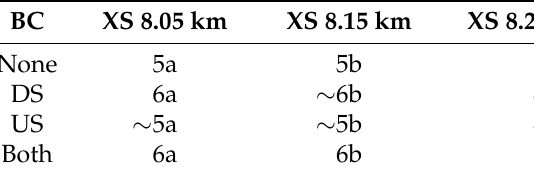
Figure 7. Two-dimensional projections of all particles X i the three hydraulic criteria from all 30 AFORAS runs for BC = Both. Since the total number of particles meeting hydraulic requirements was excessively large—142,937 out of 540,000 (30 AFORAS runs 18,000 model runs/AFORAS run)—10,000 particles were sampled to construct × each subplot, which represents one cross section (XS). Particles that perform better are plotted darker in front of those that perform worse and are in a lighter gray.